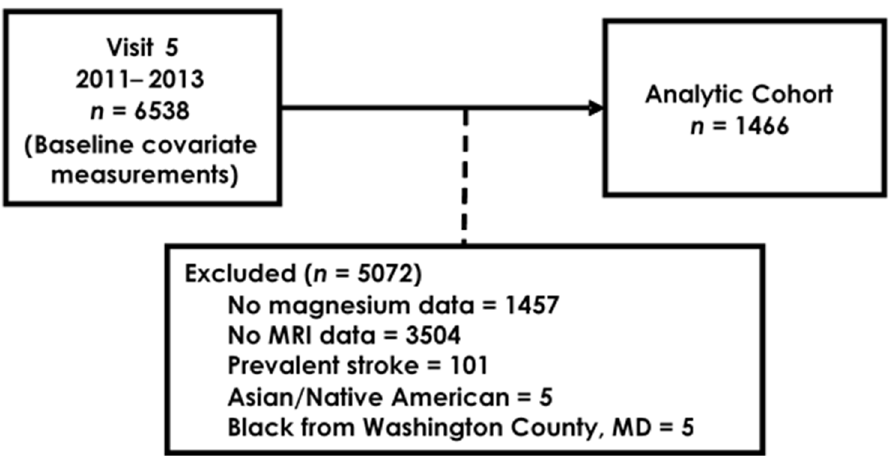
Figure 1. Flow diagram of ARIC participant selection into study.